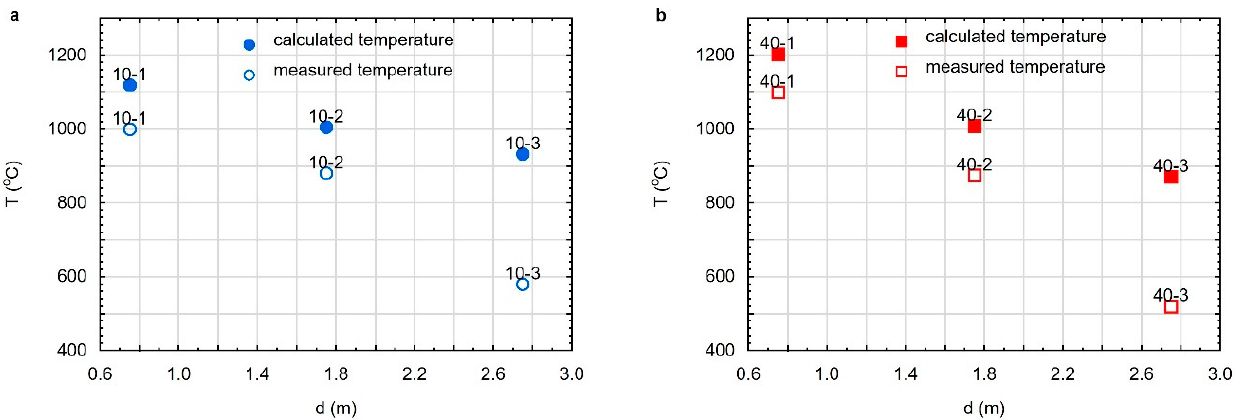
Figure 12. Relationship between measured and calculated temperature and distance from reactor chamber inlet at ( a ) pressure of 10 bar, and ( b ) pressure of 40 bar.